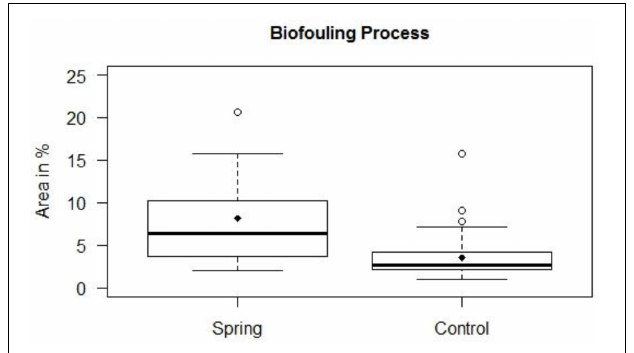
FIGURE 8 | Biofouling processes of settlement panels exposed to a submarine spring and a control section of seawater.